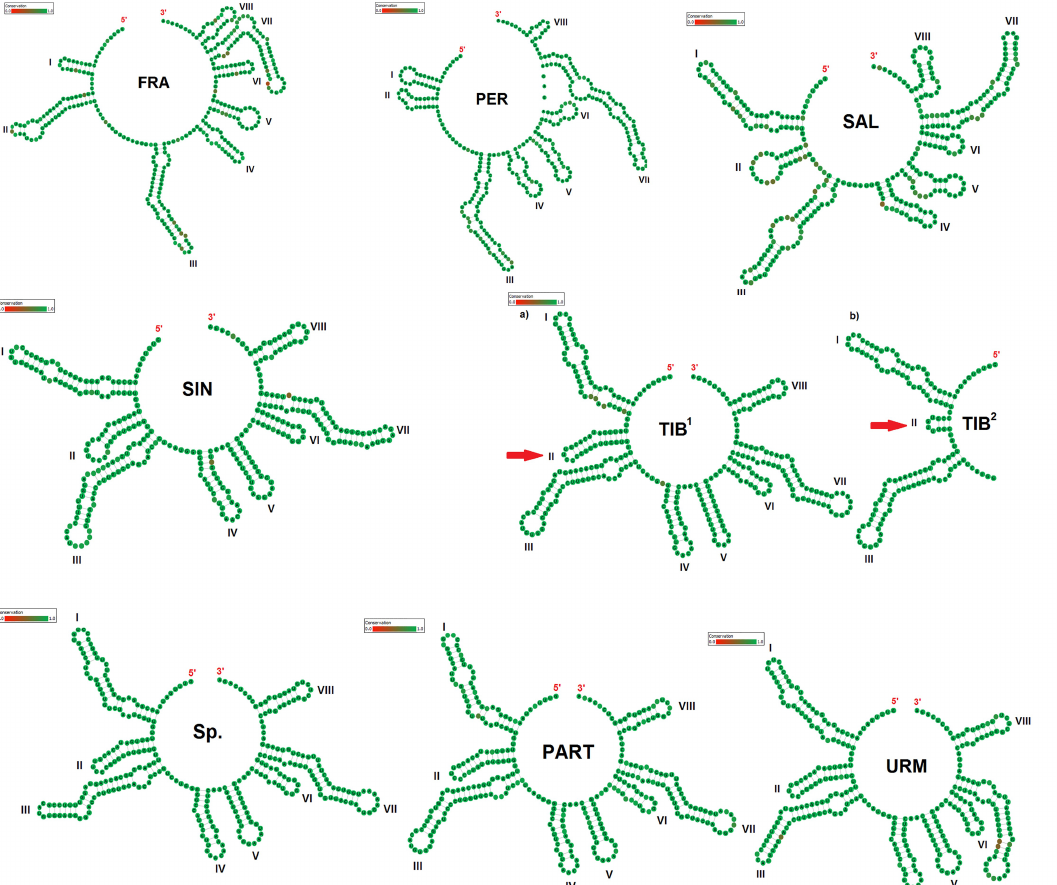
Fig. 1. Predicted general secondary structure for the ITS1 partial regions of genus Artemia : TIB 1 ; Haplotypes TIB2-5; TIB 2 ; Haplotype TIB1; Arrows point to the region with different patterns between two secondary structures of TIB. (Abbreviations of species/population are defined in Table